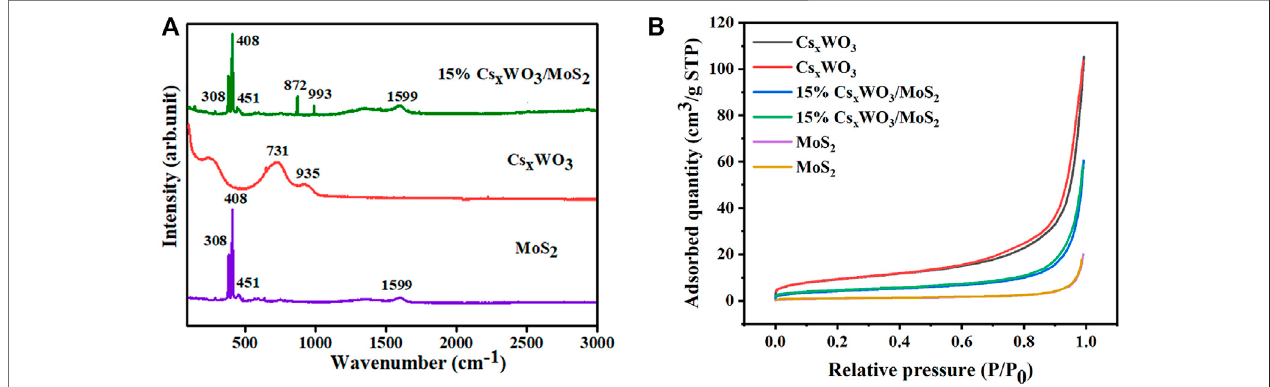
FIGURE 6 | (A) Raman spectra and (B) N 2 adsorption-desorption isotherms of the pure Cs x WO 3 , pure MoS 2 , and 15% Cs x WO 3 /MoS 2 nanocomposite.